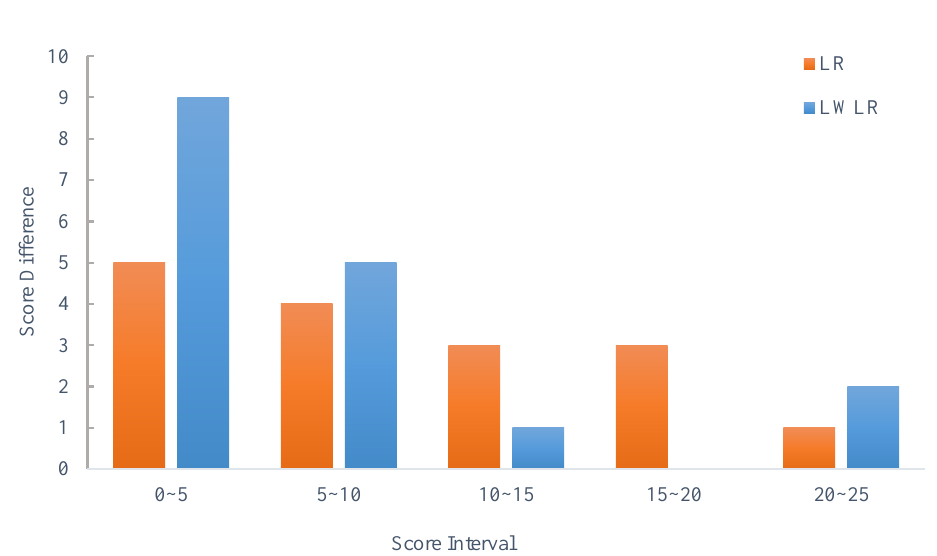
Figure 7. The results of predicted score differences between LR and LWLR.